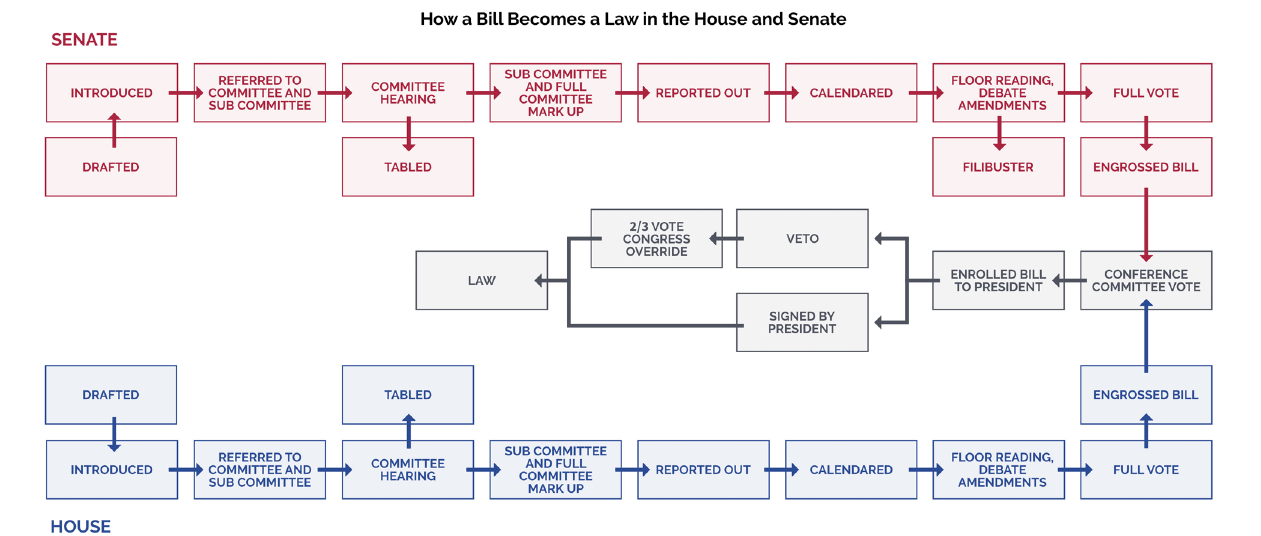
FIGURE 1 | Flow chart of legislation in the U.S. House of Representatives (blue) and Senate (red), highlighting the numerous steps a potential bill takes before being signed into law. Understanding these pathways allows scientists to engage throughout the bill’s lifetime rather than toward the end of the legislative